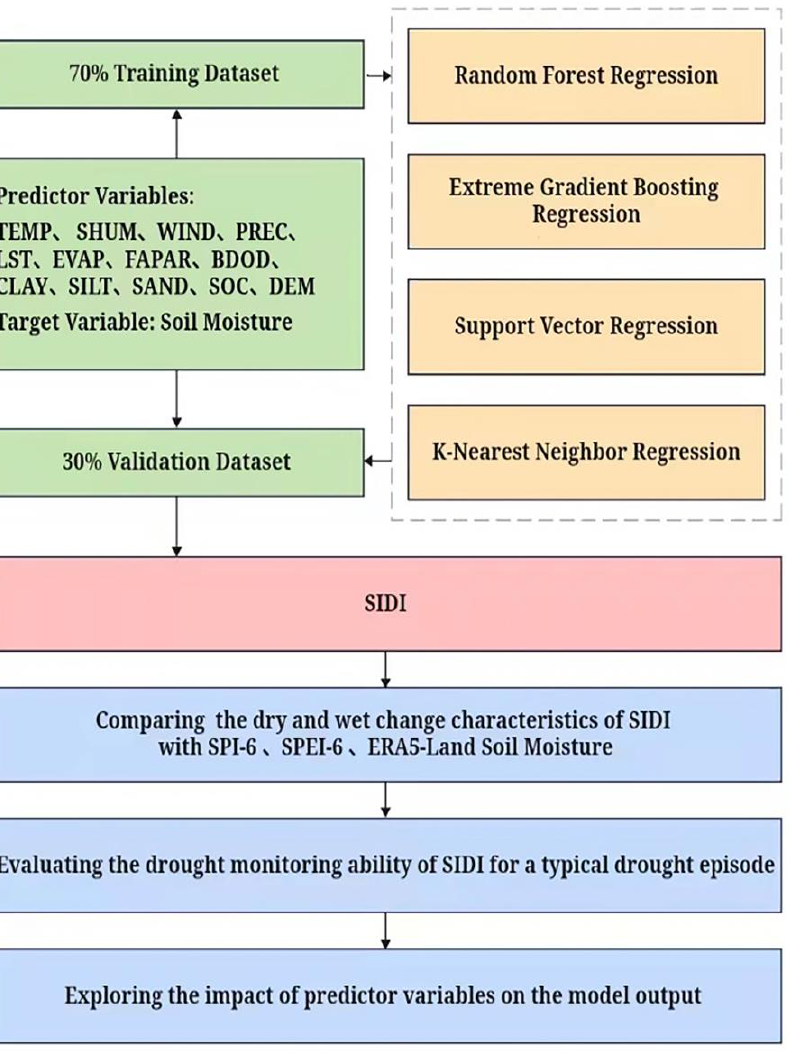
Figure 2. The technical framework for the development of SIDI. Green boxes represent the input data; yellow boxes represent the machine learning models; red boxes represent the model output; blue boxes represent the validation processes.